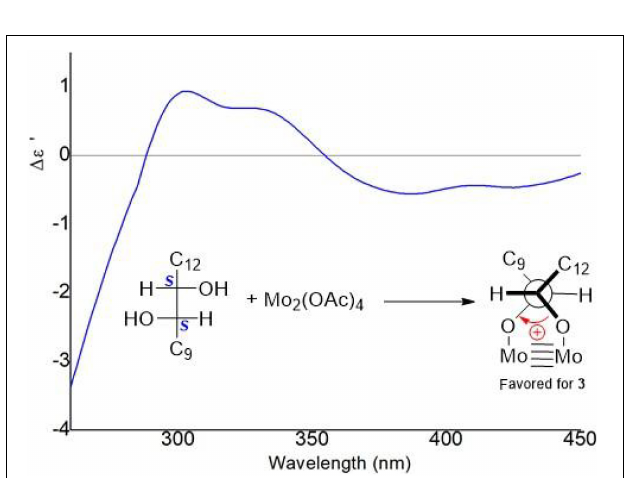
FIGURE 8 | Induced circular dichroism (ICD) spectra from the Mo 2 -complexe of 3 in DMSO.